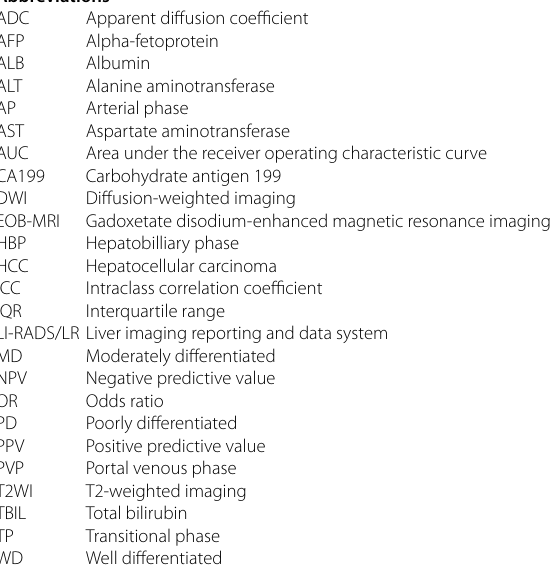
Numbers in parentheses are 95% CIs, and numbers in brackets are raw data AUC, receiver operating characteristic curve; PPV, positive predictive value; NPV, negative predictive value; ACC,